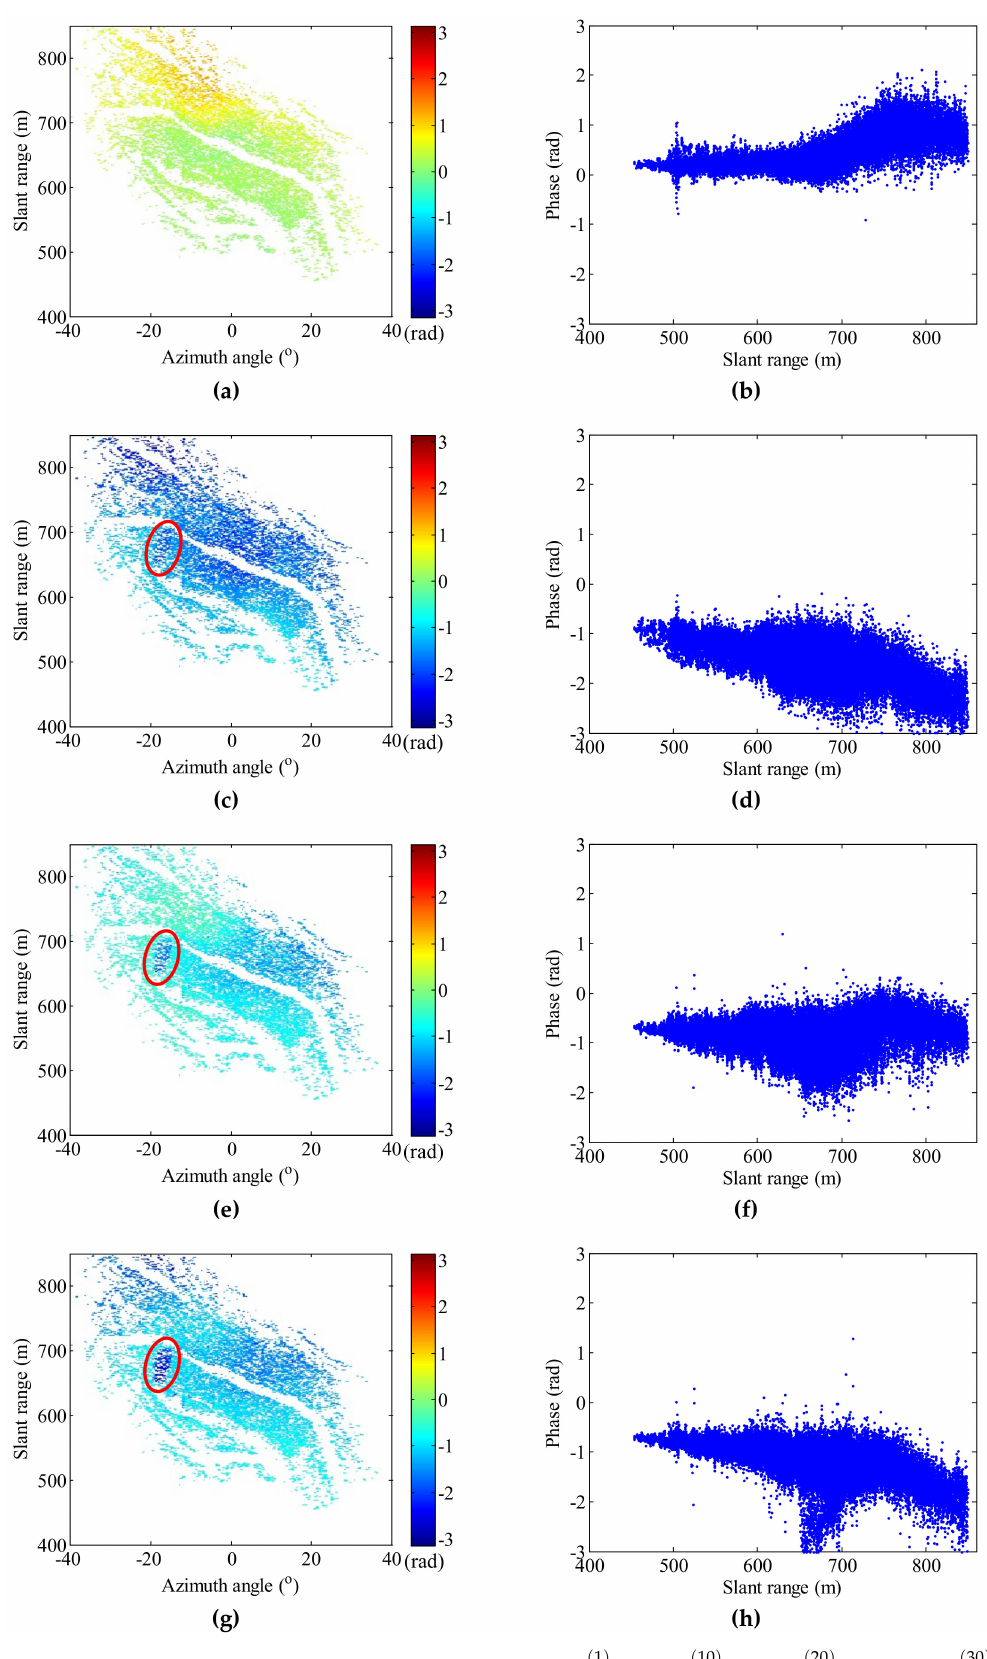
Figure 6. Four phase interferograms of Group B: ( a ) IM Corresponding scatter diagrams: ( b ) SD